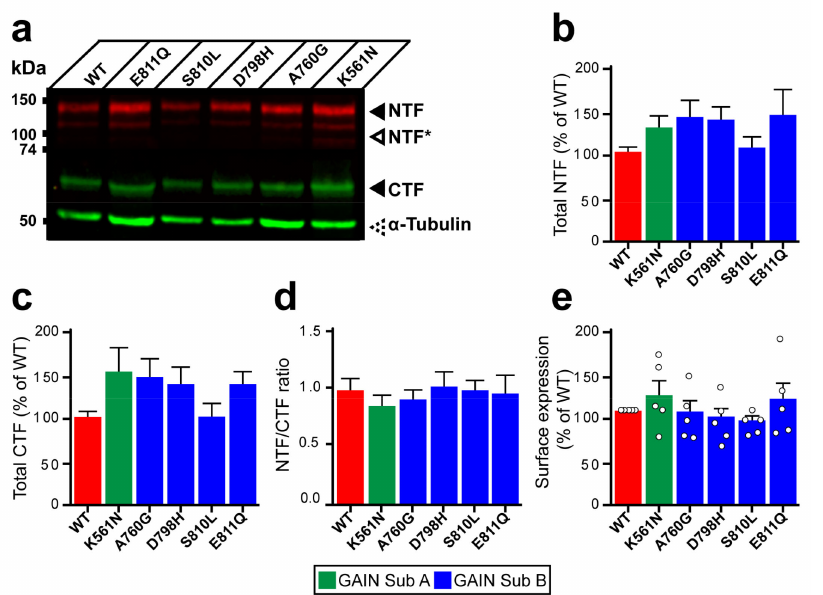
Figure 3. Expression and autoproteolysis of Lphn3 are unaltered by the presence of cancer-related GAIN domain mutations. ( a ) Western blot analysis by immunofluorescent detection of total proteins from HEK293 cells transfected with cancer-related GAIN domain mutations. NTF was detected with a rabbit anti-Flag antibody and CTF with a mouse anti-HA antibody, both distinctly labeled with corresponding secondary fluorescent antibodies. NTF* represent fragments resulting from unknown posttranslational modifications. Immunodetection of α -tubulin was used as a protein loading control. ( b , c ) Quantification of normalized fluorescent immunodetection data obtained in ( a ) for NTF and CTF, respectively. ( d ) Cleavage efficiency quantification expressed as NTF/CTF ratios. Data from b-d are represented as the mean values obtained from at least four independent experiments with error bars representing S.E.M. ( n = 4). ( e ) Detection of cell surface expression assay (DECS) for Flag-tagged Lphn3 and cancer-related GAIN domain mutations using a colorimetric reaction quantifying the acid- stopped conversion of Horseradish-peroxidase substrate, which is detected at a 450 nm absorbance wavelength. Subdomain A (GAIN Sub A) and B (GAIN Sub B) of GAIN domain. Statistical analysis was performed using one-way ANOVA. Each white circle symbol represents the mean value of four replicates obtained from one independent experiment. Data were normalized to Lphn3-WT and are represented as the mean values obtained from at least five independent experiments of four replicates, each with error bars representing S.E.M. ( n =